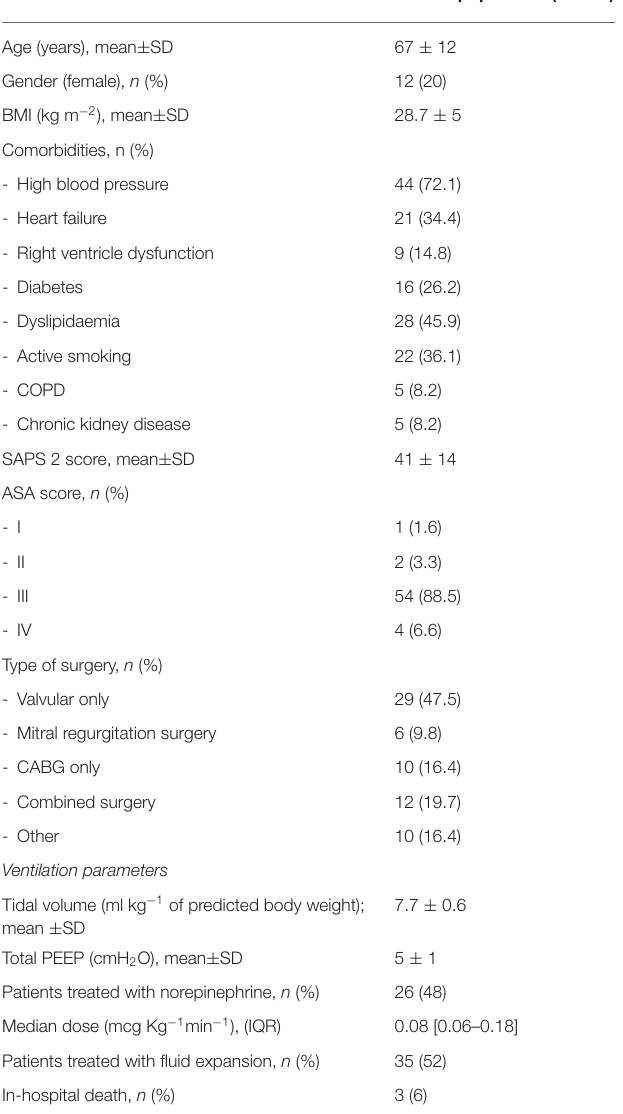
TABLE 1 | Characteristics of the study participants on inclusion. Variables